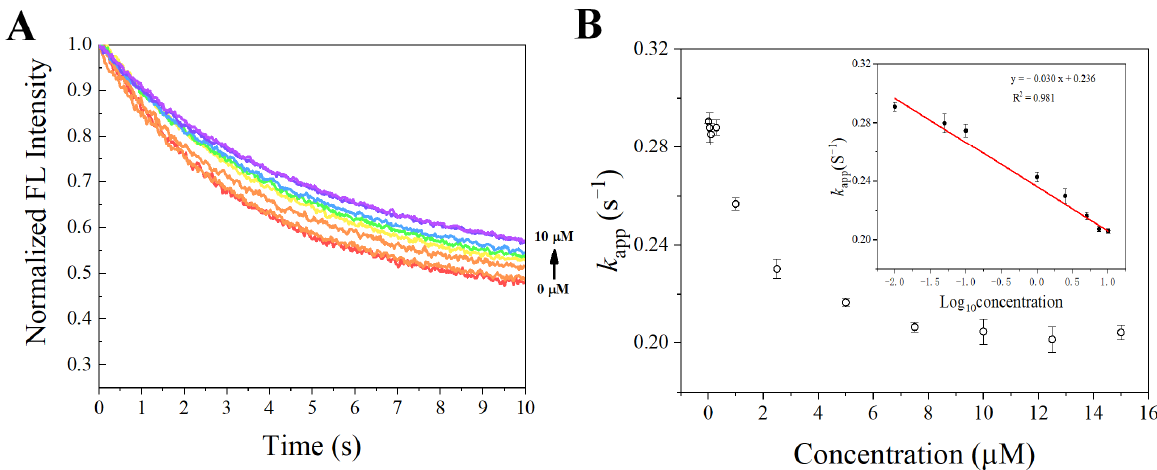
Figure 6. ( A ) Fluorescence attenuation curves of SITS-Thrombin27 5 ′ in the presence of various thrombin concentrations. ( B ) The calculated k app value as a function of thrombin concentration; insert shows that the change in k app is linear with logarithm of thrombin concentration over the range from 0.3 to 10 µ M.